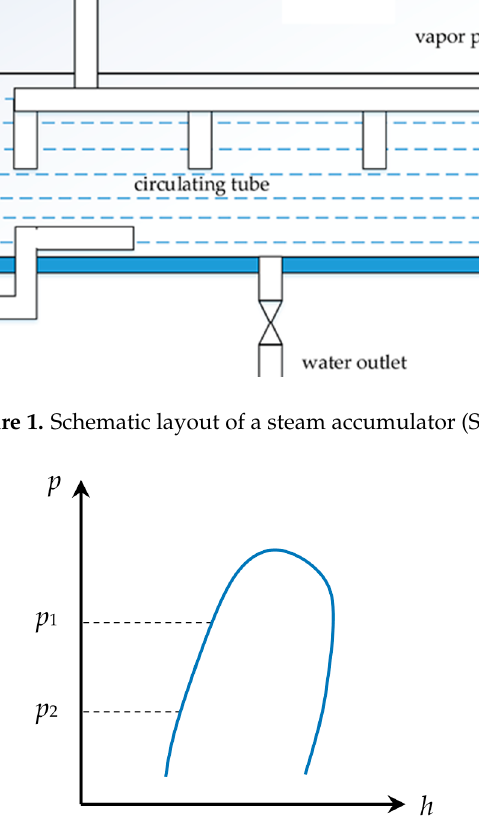
Figure 2. Pressure-enthalpy diagram of steam storage and release processes. Pressure varies within p 1 to p 2 in the whole SA operating process.